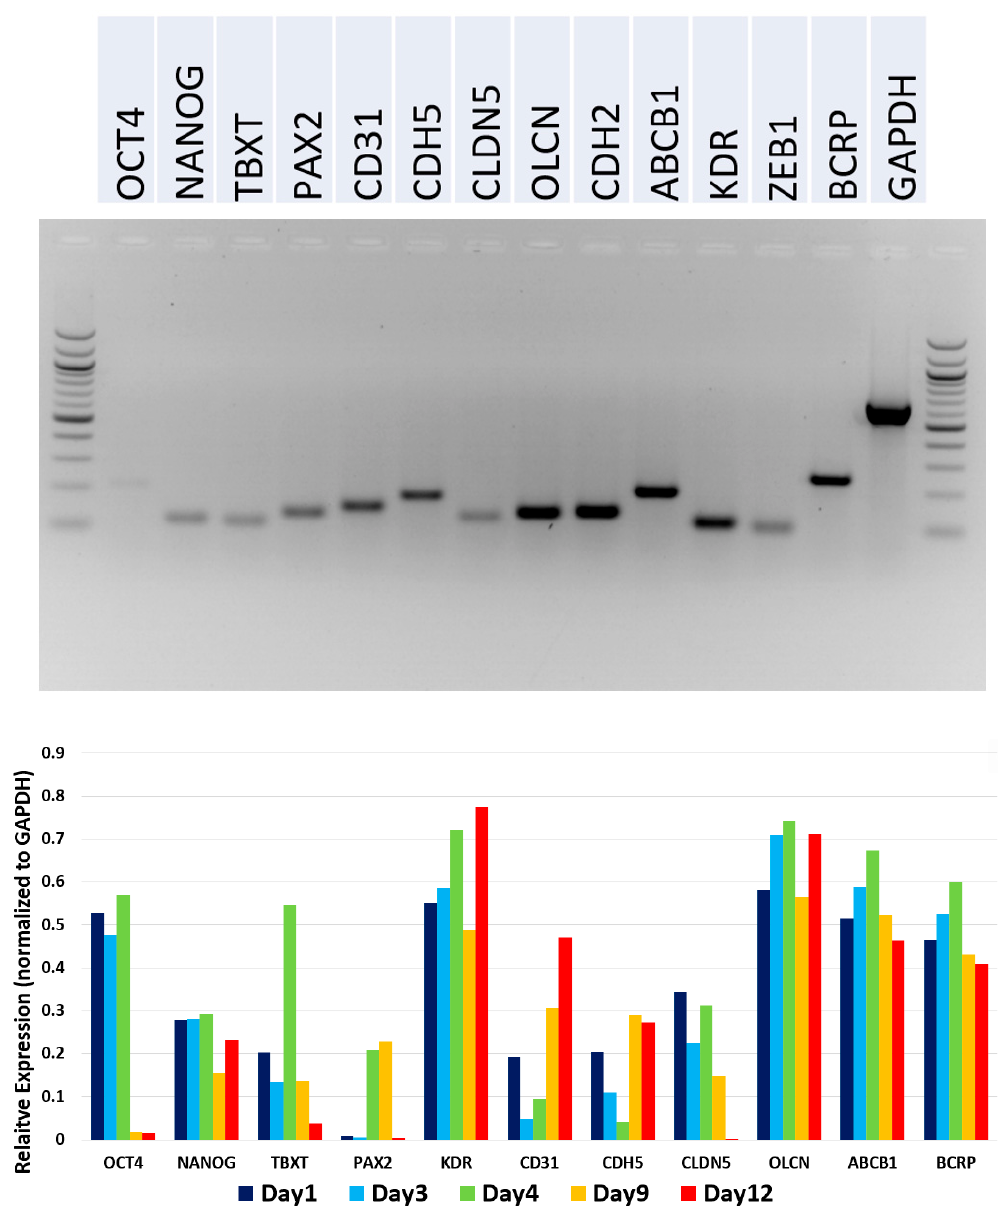
Figure A2. Expression patterns of specific biomarkers along the iPSC differentiation procedures.